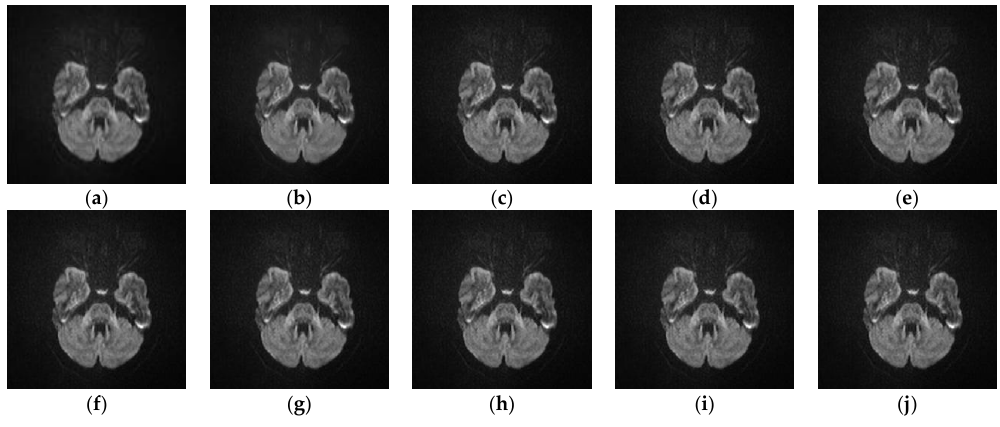
Figure 10. Comparison of the reconstructed images with different SR algorithms for medical image2 .